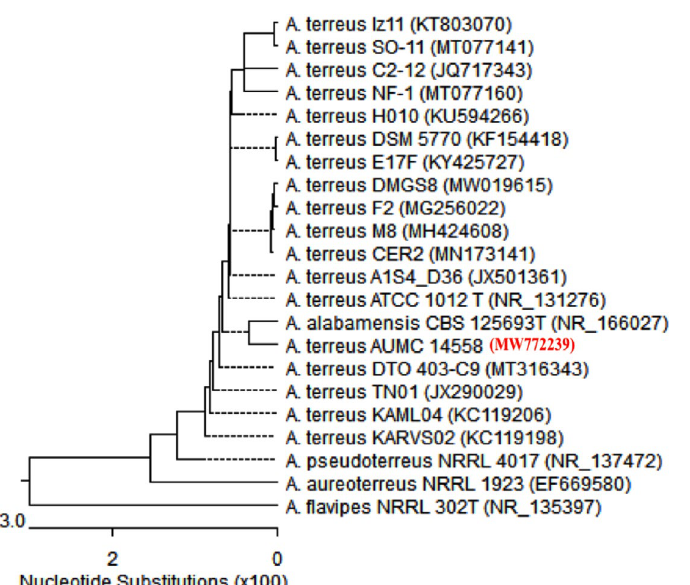
Fig. 2. Phylogenetic tree depending on ITS region sequence of 18S rDNA of the fungal isolate in the current investigation ( Aspergillus terreus